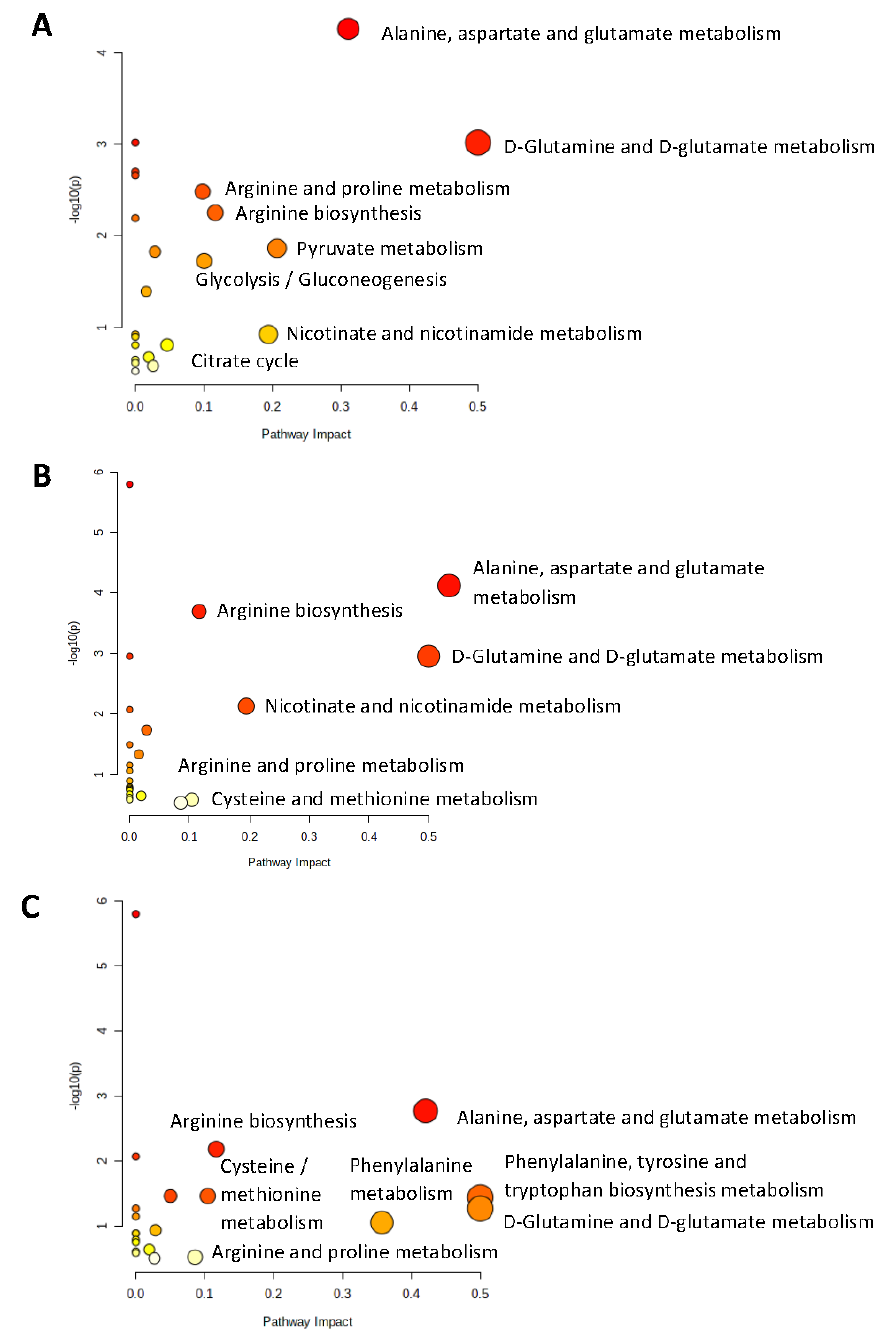
The metabolic pathways identified to be perturbated between patients with RRMS vs. the controls and between patients with CIS vs. the controls are shown in Figure 3A,B.